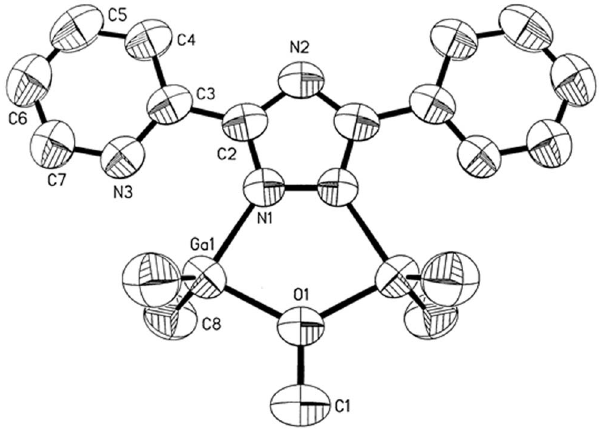
Figure 5. Molecular structure of 4 (50% probability thermal